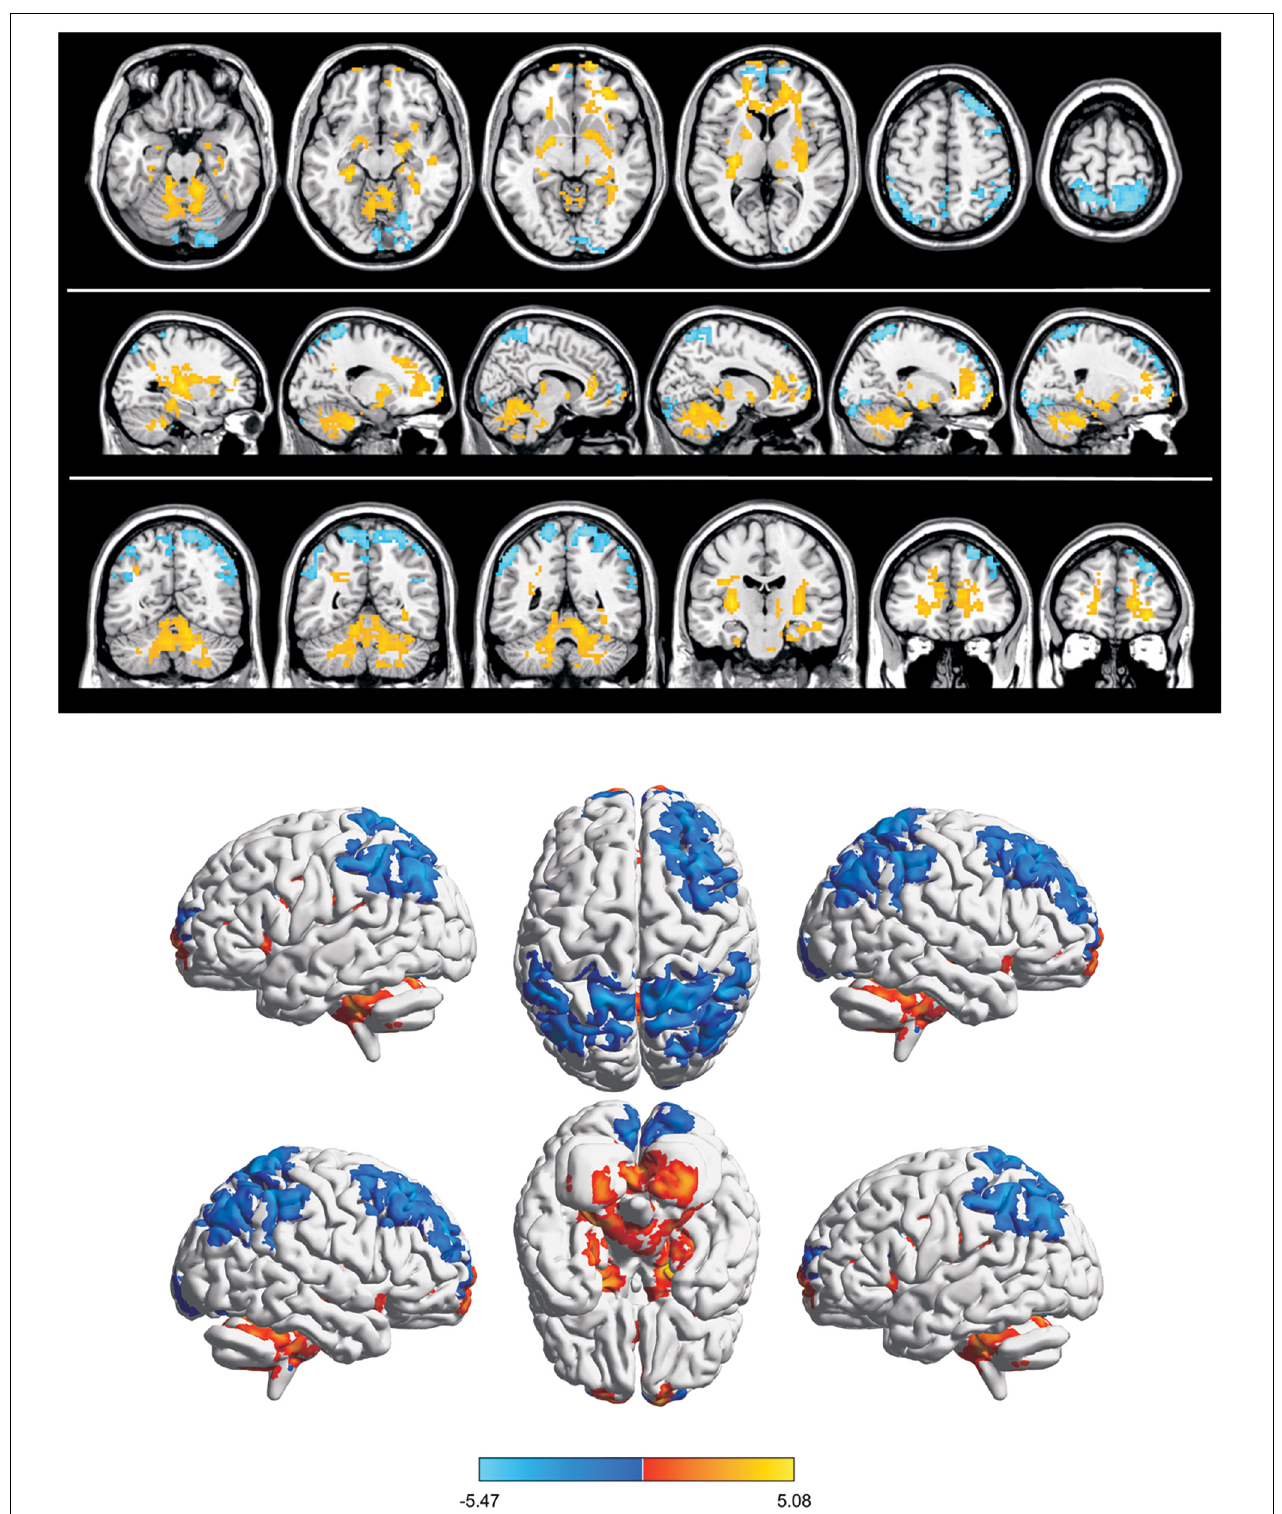
FIGURE 2 | Spontaneous brain activity in SA group. Blue regions (right cerebellum, left frontal superior gyrus, and left putamen nucleus) indicate lower reHo values, whereas red regions (right parietal superior gyrus, left parietal superior gyrus, right lingual gyrus, right frontal superior medial gyrus, and right parietal inferior) show higher ReHo values (AlphaSim-corrected, P < 0.05,cluster size > 40).